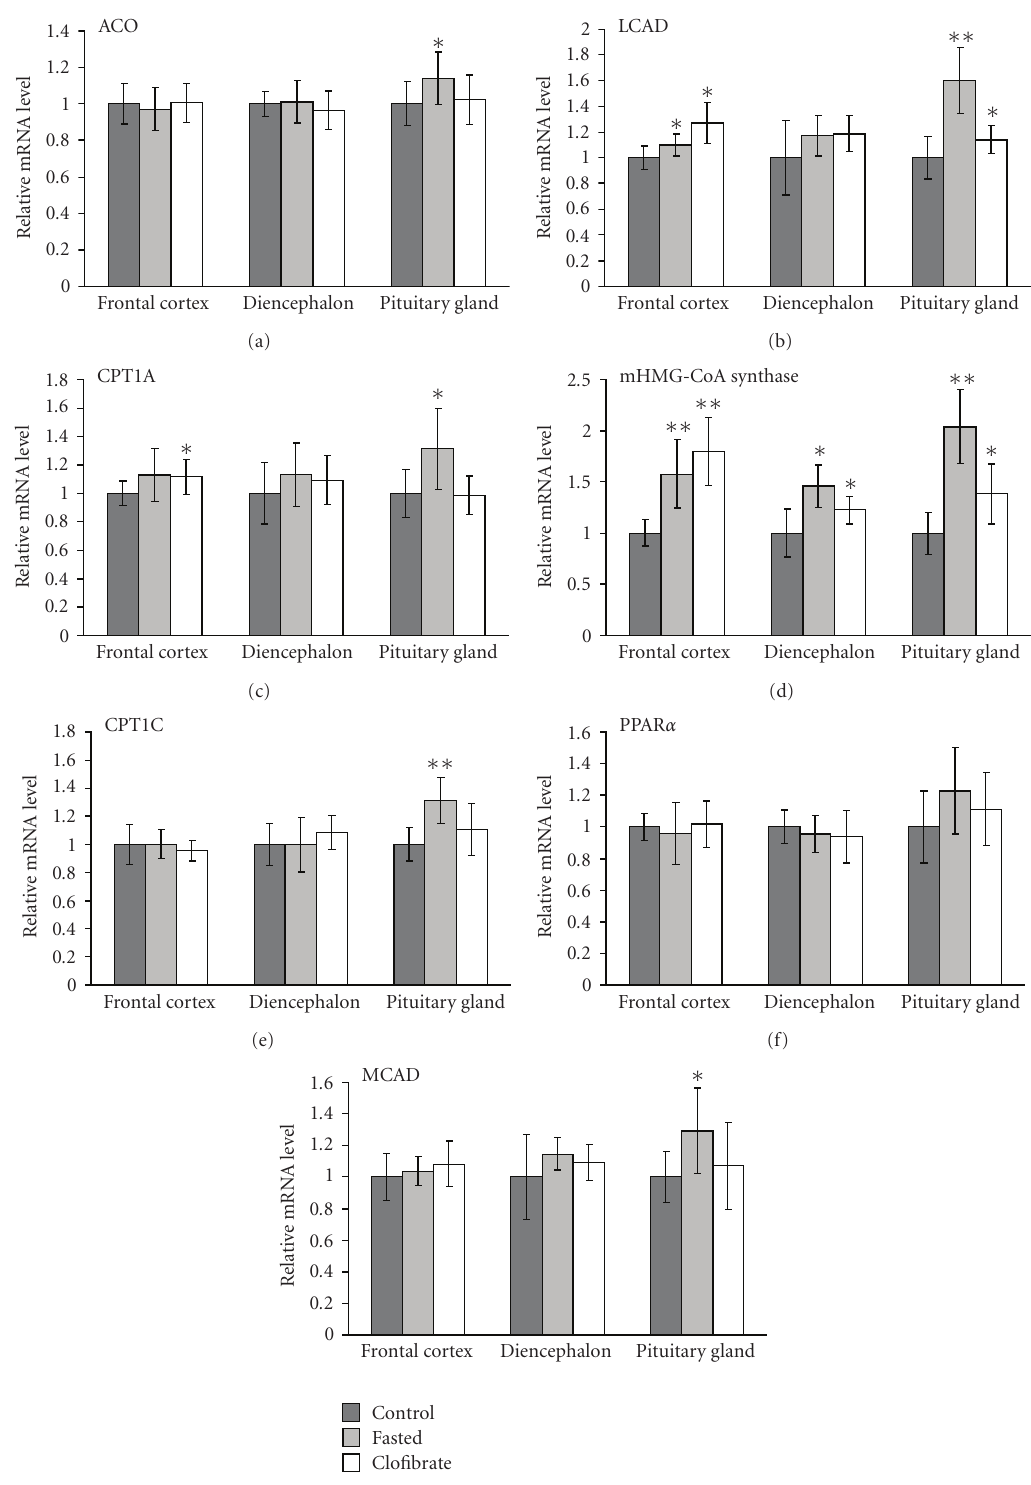
Figure 1: E ff ect of fasting or clofibrate treatment on mRNA concentration of acyl-CoA oxidase (ACO), carnitine palmitoyltransferases (CPT)-1A and -1C, medium chain acyl-CoA dehydrogenase (MCAD), long chain acyl-CoA dehydrogenase (LCAD), mitochondrial 3- hydroxy-3-methylglutaryl-(mHMG)-CoA synthase, and peroxisome proliferator-activated receptor (PPAR)- α in di ff erent brain areas of rats. All rats obtained a standard basal diet for 4 days. Animals of the fasting group were fasted 36 hours before killing. Rats of the clofibrate group were treated orally with 250 mg/kg of clofibrate per day. Values are means ± SD ( n = 9). Symbols indicate significant di ff erence from control rats ( ∗ P < . 05, ∗∗ P < .